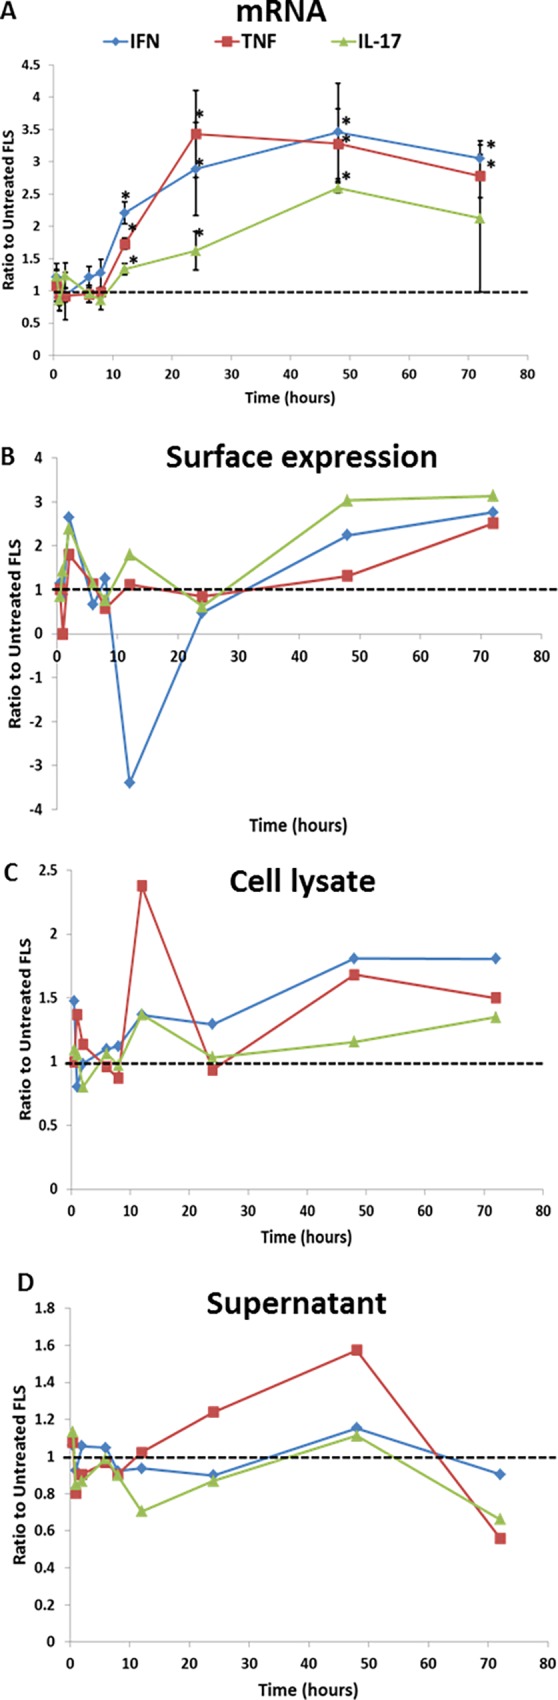
CD13 is upregulated in FLS at the mRNA level but the effects on CD13 protein levels are varied.FLS were stimulated over a time course of 0–72 hours with IFNγ (1000U/ml), TNFα (10ng/ml), or IL-17 (10ng/ml). Cells were harvested and processed for either mRNA (A), surface expression (B), total cell lysate CD13 (C), or total CD13 in supernatant (D). mRNA was measured by qRT-PCR. CD13 was measured on the surface with anti-CD13 (1D7) and flow cytometry. Cell lysate and supernatant CD13 concentrations were measured by CD13 ELISA. Gating was done to isolate the major cell population and exclude debris and dead cells. Data is expressed as a ratio to unstimulated FLS at the same time point in either ΔΔCt normalized to GAPD (mRNA), mean fluorescent intensity corrected for background florescence with MsIg staiming (surface), or CD13 concentration in lysate or supernatant. A n = 3 B-D n = 1 *p≤0.05